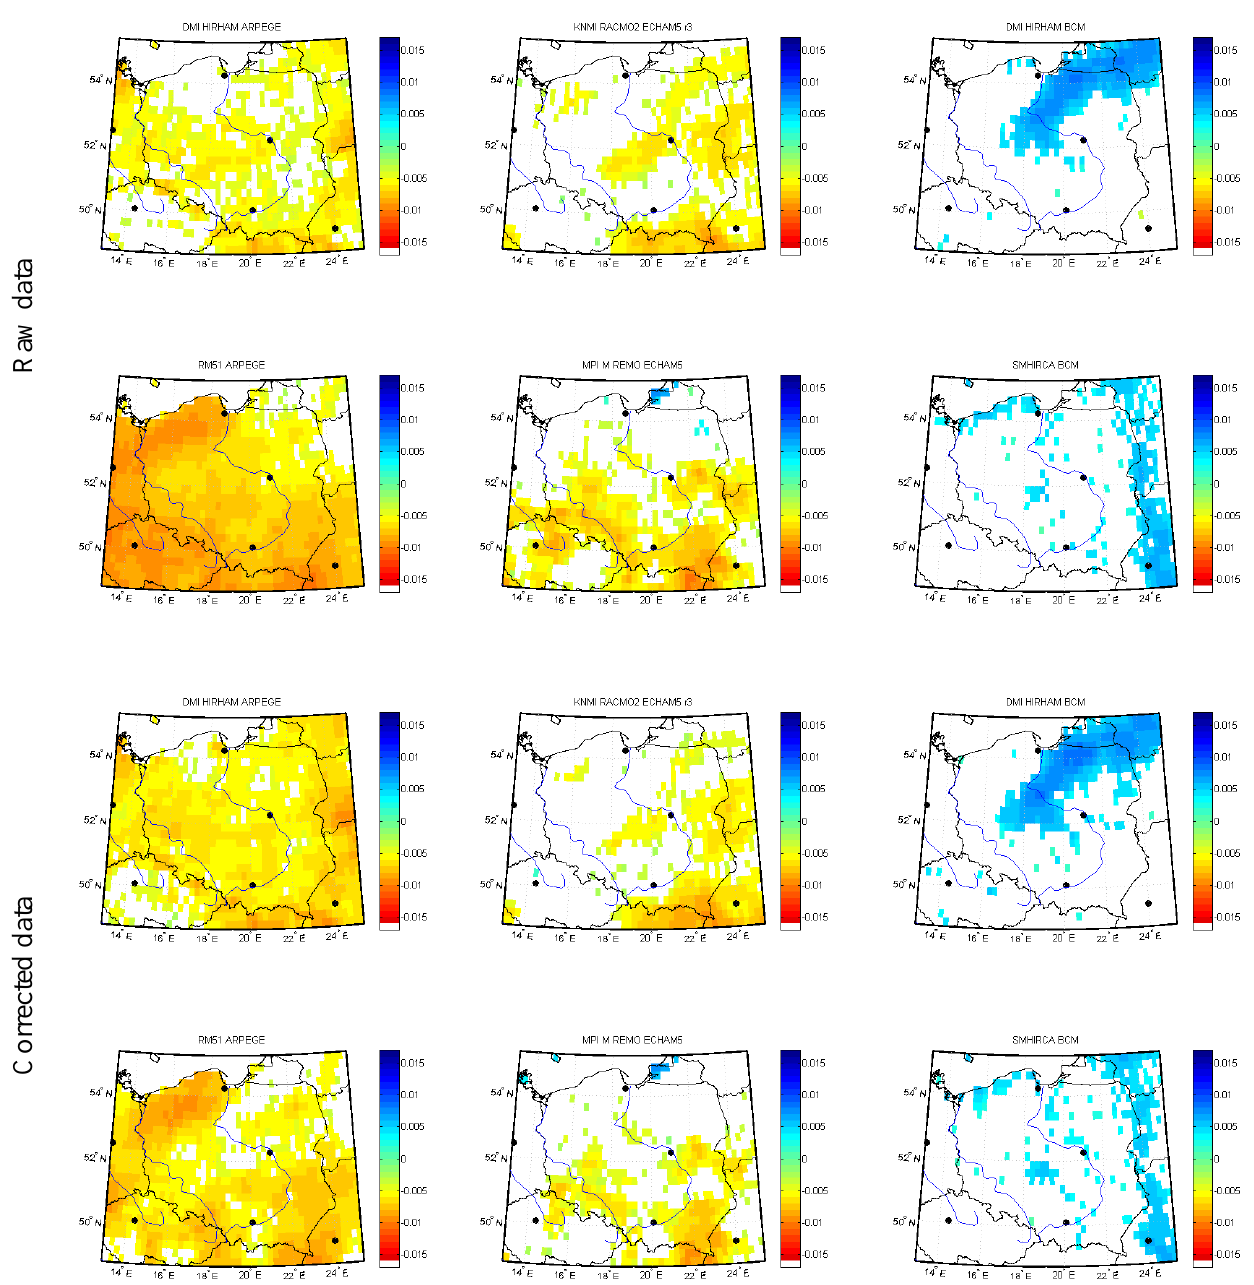
Figure 12. Trend for the SPI 3 for the summer period (JJA). The colour scale denotes the slope of the estimated trend. The white areas indicate the lack of a statistically significant